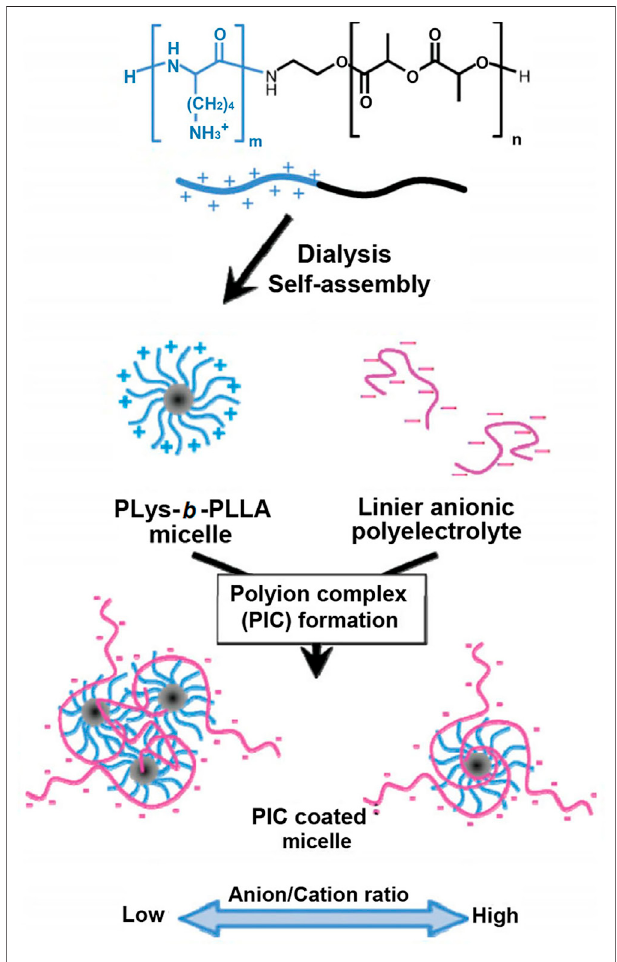
FIGURE 8 | Schematic illustration for the preparation of HA-coated micelles (Ohya et al., 2010). Abbreviation: HA, hyaluronic acid; PLys, poly(L-lysine); PLLA,